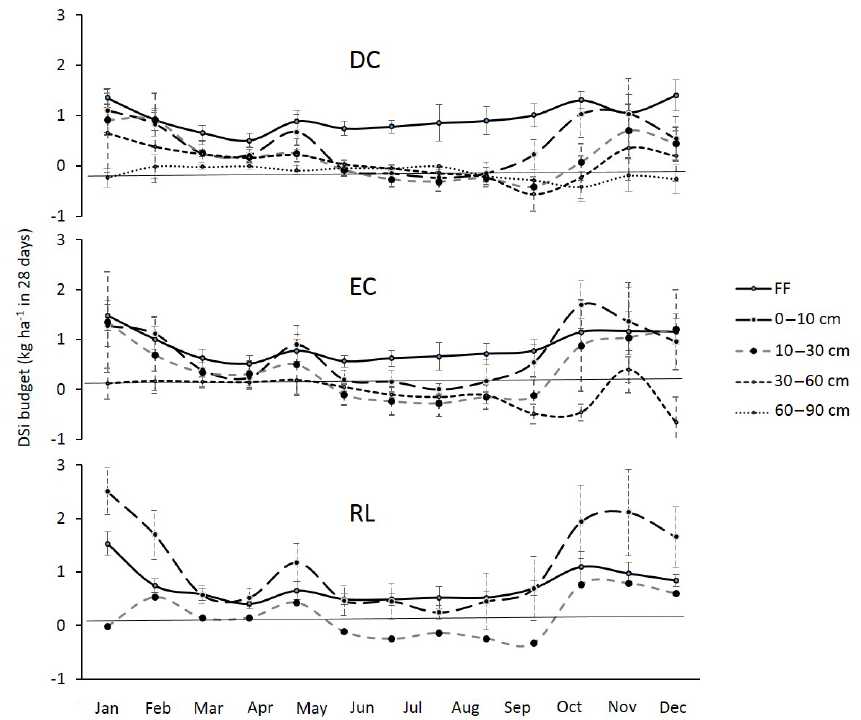
Figure 3. Seasonal dynamics over 4 years (January 2012 to December 2015) of the DSi budget in the different layers (forest floor, FF; soil 0–10cm; soil 10–30cm; soil 30–60cm; and soil 60–90cm) for the three plots, DC, EC and